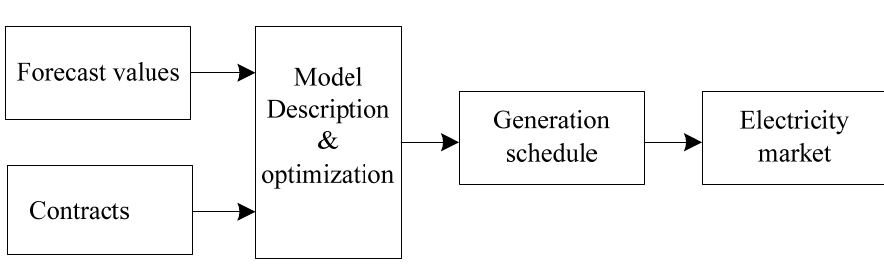
Figure 6. Flowchart of